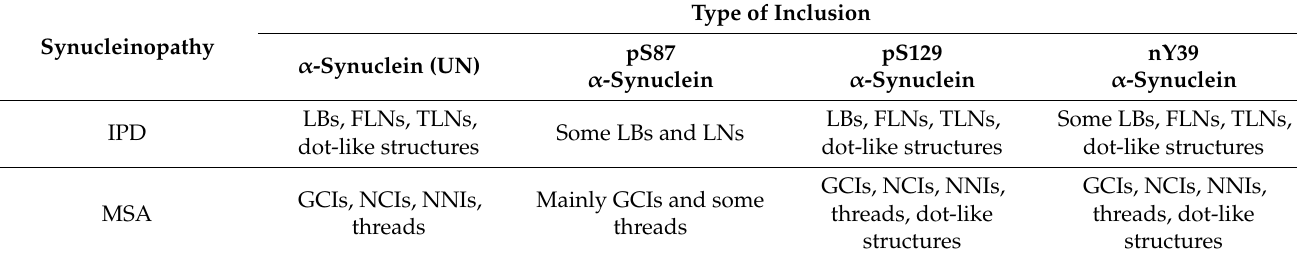
Table 4. Summary of pathological aggregates stained with various α -synuclein antibodies in IPD and